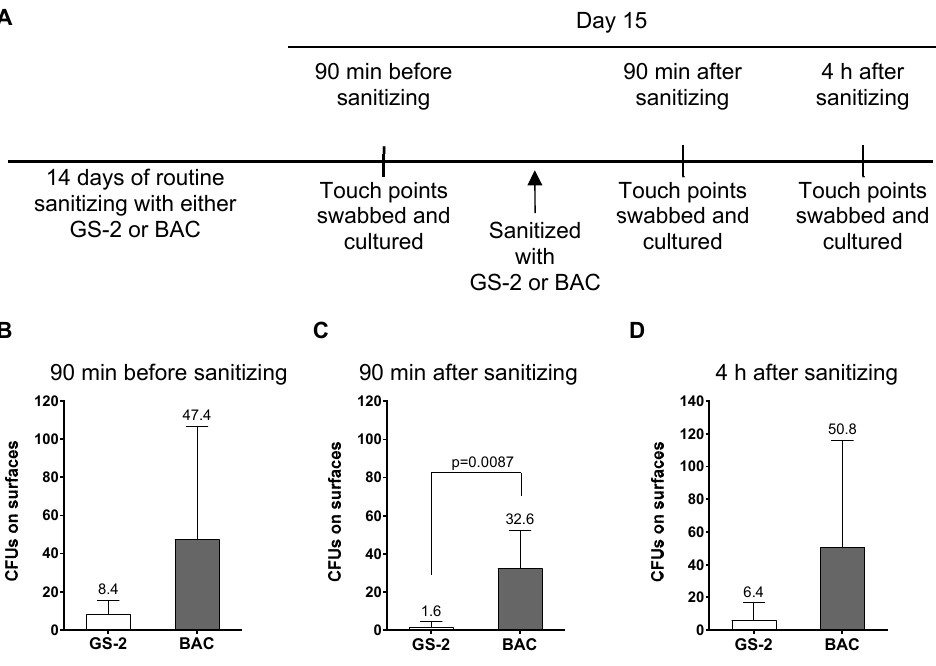
Figure 3. GS-2 compared to 0.42% BAC as a surface sanitizer. ( A ) Two commercial high-rise buildings were sanitized for 14 days with either GS-2 at 15 mg/mL or with a hospital-grade disinfectant containing 0.42% BAC according to product label instructions. On day 15, swabs were taken from both buildings at five high-touch-point surfaces ( B ) before sanitizing, ( C ) 90 min after sanitizing, and ( D ) 4 h after sanitizing. Swabs were then cultured on 5% SBA plates for 24 h at 37 °C, and the number of colonies counted. (Data represent mean ± SD; C, unpaired two-tailed t -test).